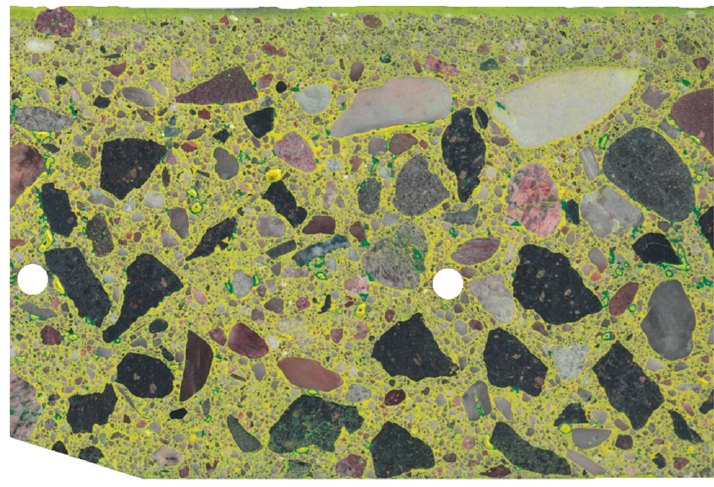
Figure 9. Image of the tested sample after staining the matrix (limited to the region of interest (ROI)).